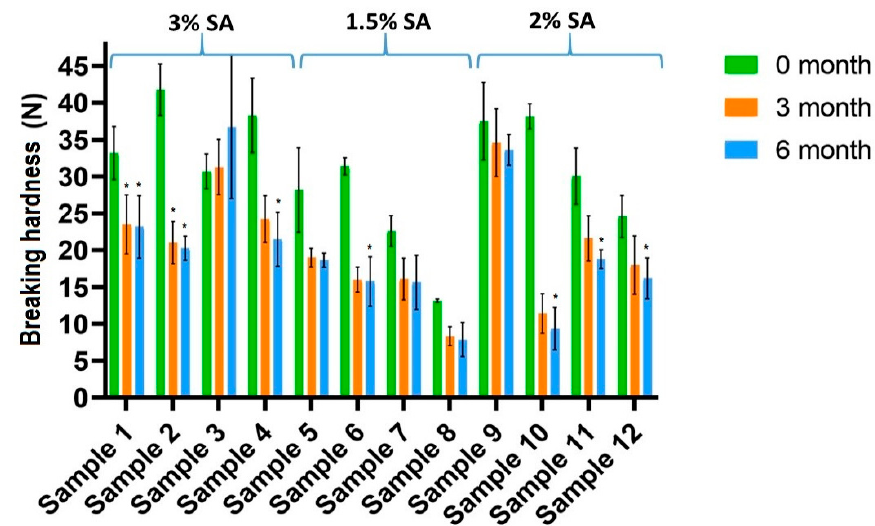
Figure 1. Breaking hardness of the prepared films (Samples 2, 4, 6, 8, 10, 12 contain CA) (* p < 0.05; n = 6). The samples were compared to the freshly prepared sample (0 months).